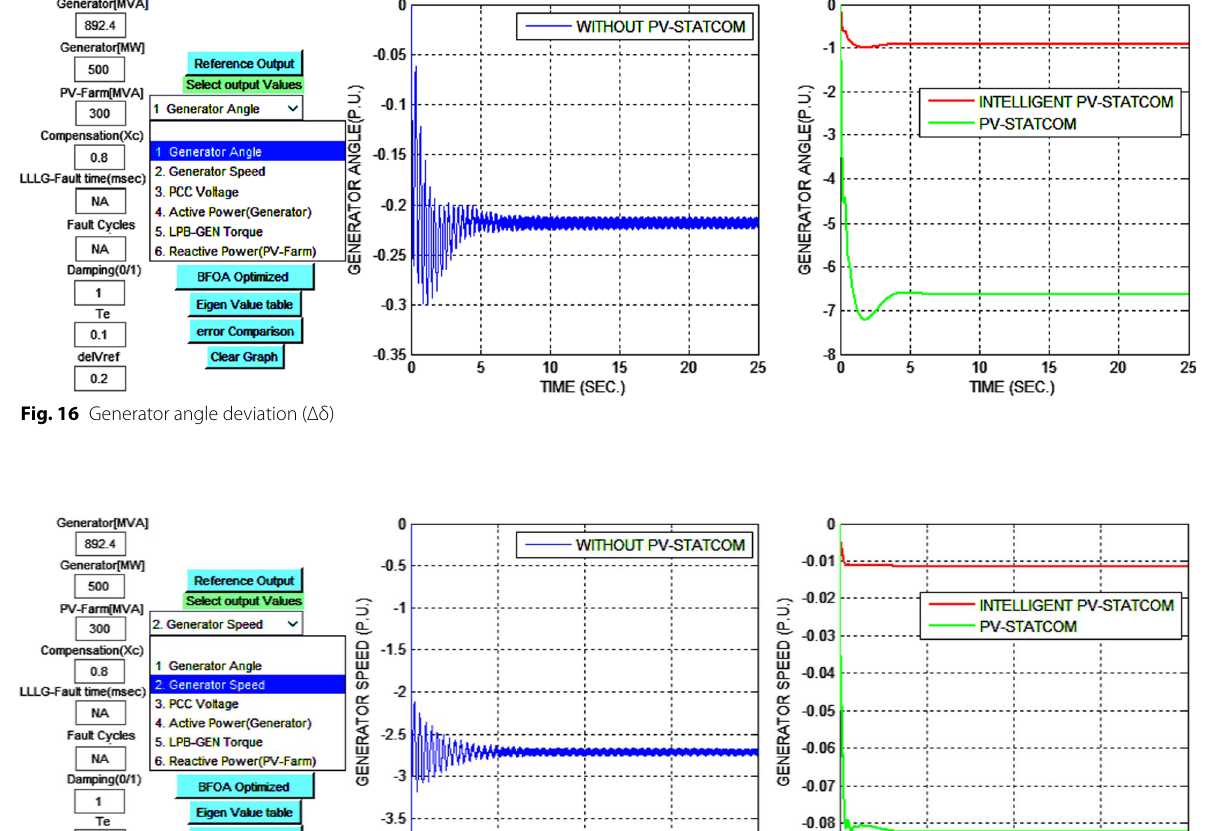
Bold indicates Percentage(%)